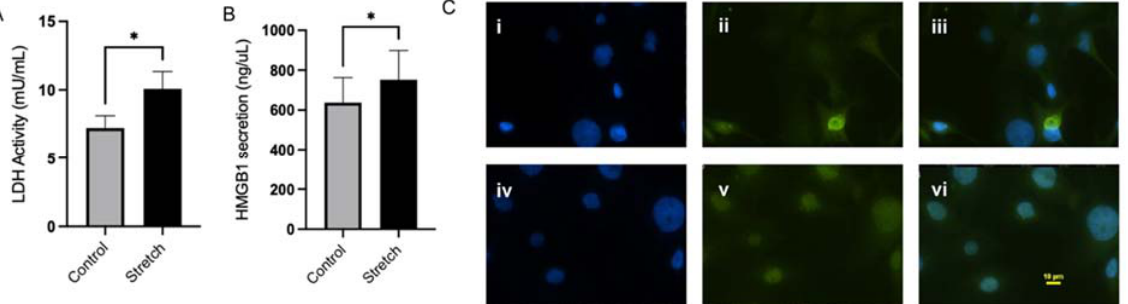
Figure 1. Mechanical stretch increased LDH activity, HMGB1 secretion, and activation of NF-kB. ( A ) Kinetically measured LDH activity (mU/ µ L) was increased with stretch. ( B ) ELISA quantification of HMGB1 (ng/ µ L) from cell culture supernatants of 4 h stretched and control of not stretched hAECs. Data displayed as mean ± STDEV. * p < 0.05 vs. control (Student’s t -test). ( C ) Immunofluorescent analysis of nuclear localization of p65 protein in hAECs. ( i , ii ) DAPI-blue (1 µ g/mL) and p65 (1/500) staining of control primary amnion epithelial cells, respectively. ( iv , v ) DAPI and p65 staining of stretched primary amnion epithelial cells, respectively. ( iii , vi ) Merged DAPI and p65 signal of control and stretched cells, respectively.